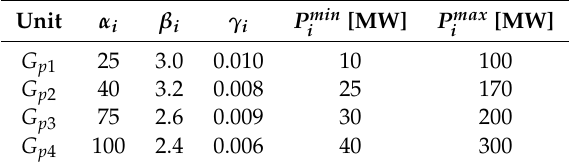
Table A1. The operation cost function parameters and output limit parameters of power-only units.